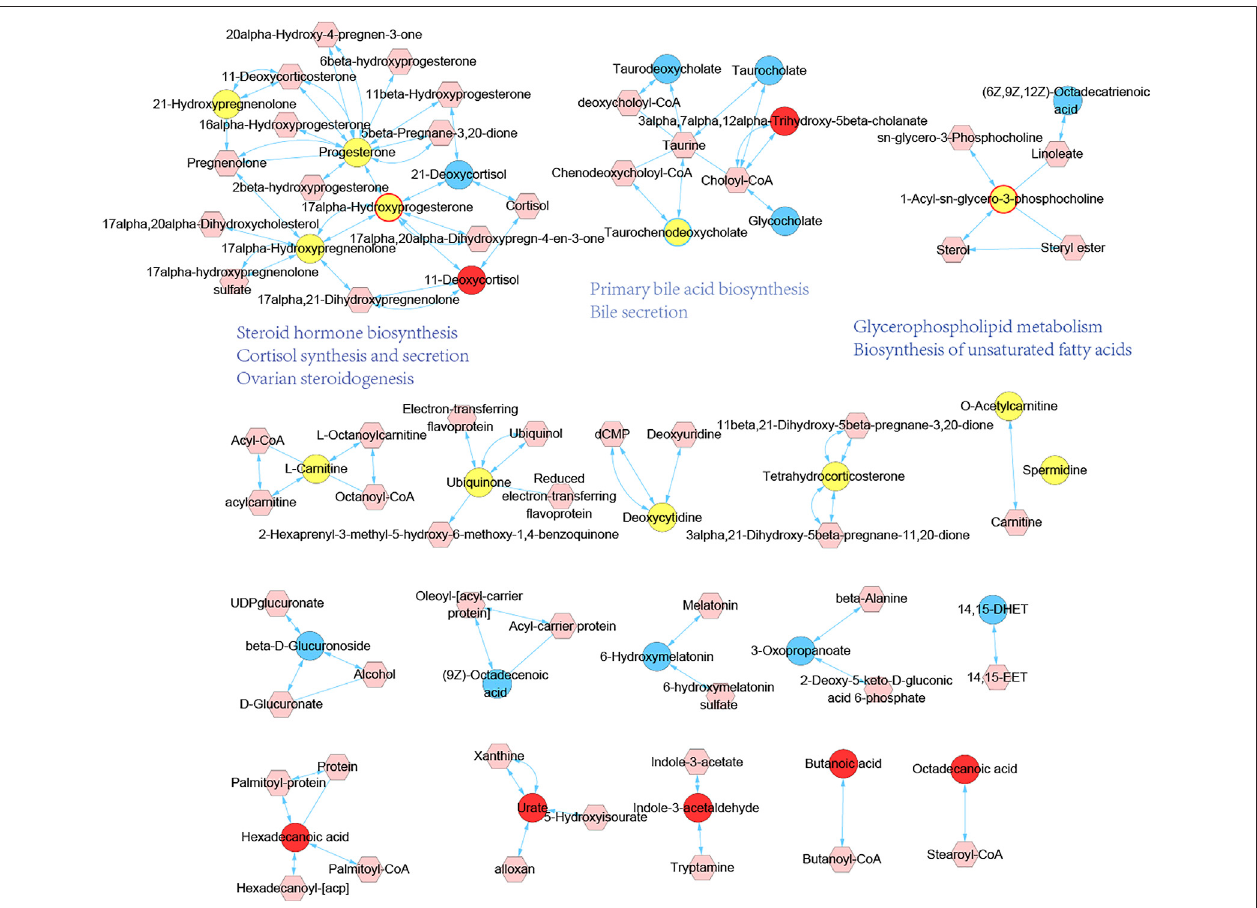
FIGURE 6| Metabolic modules affected by HHXYT treatment and their functions. Circle nodes areendogenous differential metabolites identi fi ed in metabolomics, and hexagonal nodes are metabolites close to the endogenous differential metabolites in the genomic metabolic network which were identi fi ed by the diffusion kernel algorithm.Yellow circlesareendogenousdifferentialmetabolitesinMGH,whilecircles withblueand redcolorsorborderswereinHHXYT-L andHHXYT-H, respectively.